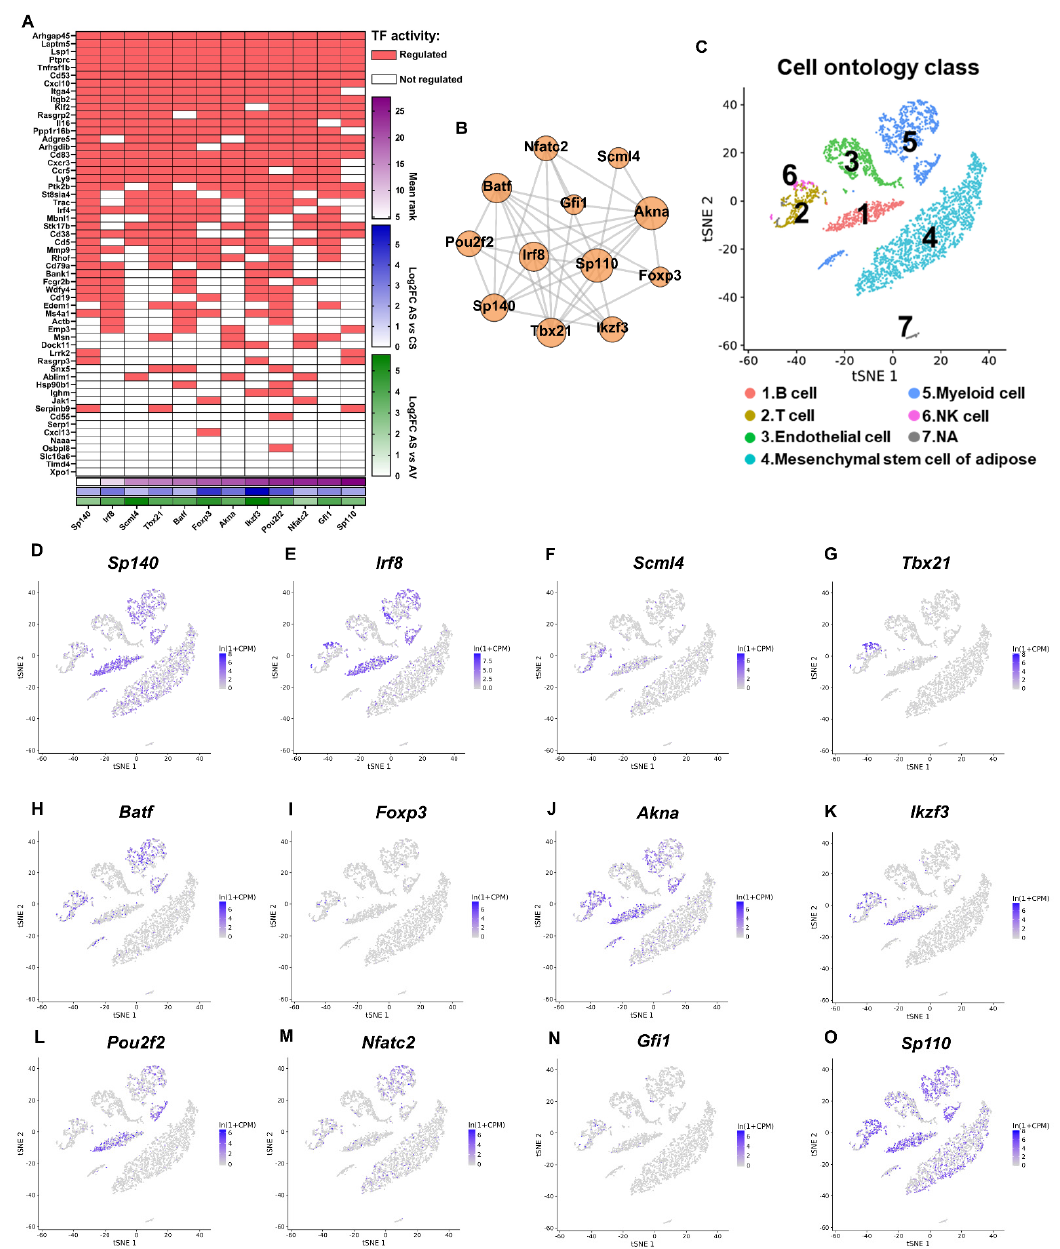
Figure 7. ADX-reversed and inflammation-associated DEGs are mainly transcriptionally regulated by 12 transcription factors. ( A ) Inferred transcriptional regulators of 93 ADX-reversed and inflam- mation-associated genes via ChEA3. The criteria of the mean rank < 30 was used for the TF selection, as recommended by the authors. ( B ) TF-TF co-regulatory networks of the 12 key TFs. The network